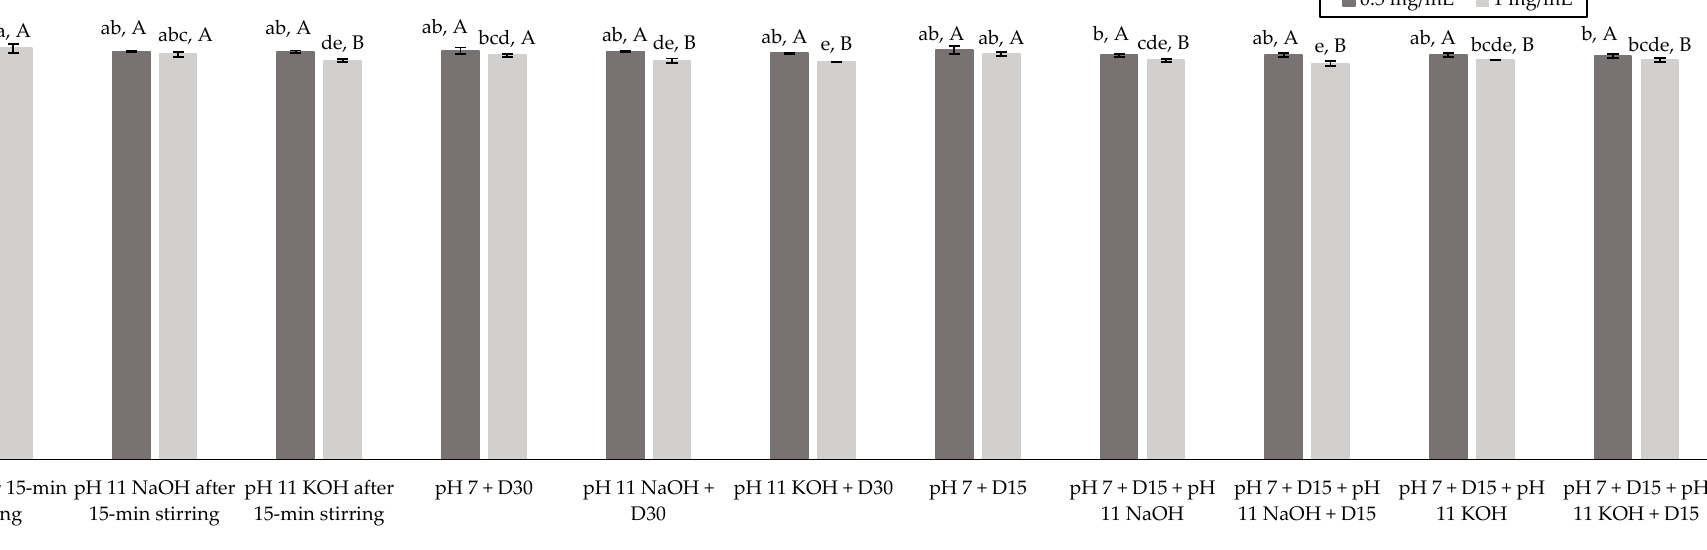
Figure 3. Antioxidant activity of the HMH solutions corresponding to the different tested conditions and determined by the DPPH test (mean ± standard deviation) expressed in DPPH scavenging activity (%). Values with different lowercase letters (a–e) within the same concentration are significantly different p < 0.05 (Tukey test); values with different uppercase letters (A,B) within the same condition are significantly different p < 0.05 ( t -test).